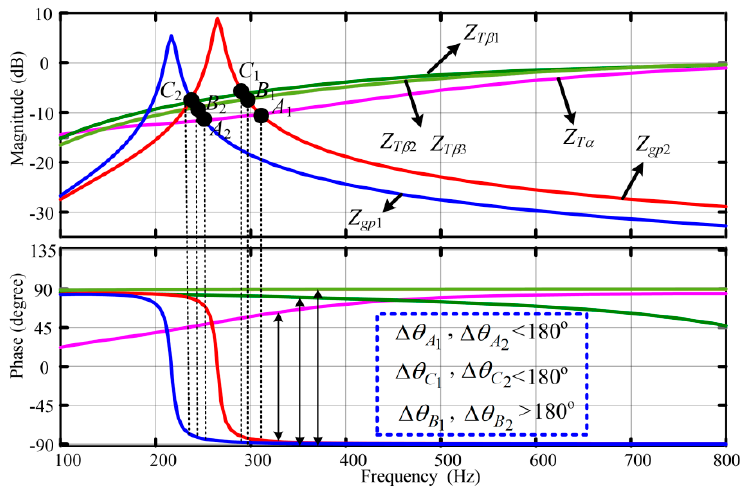
Figure 10. Bode plot of DFIG impedance and parallel compensated weak grid with low, medium, and high bandwidth SRF-PLL.